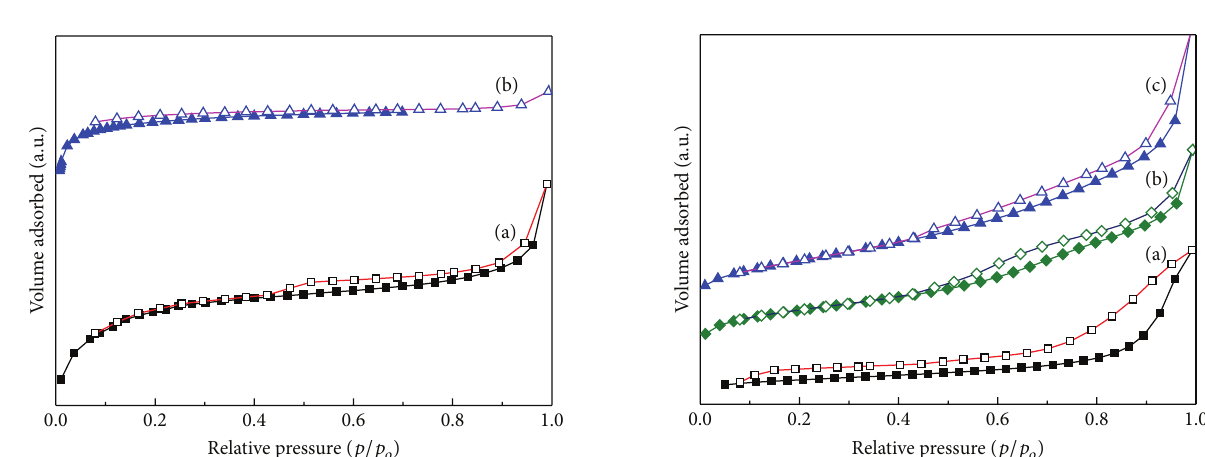
Figure 8: N 2 adsorption isotherms of the iron oxide samples. (a) FO-0, (b) FO-1, and (c)